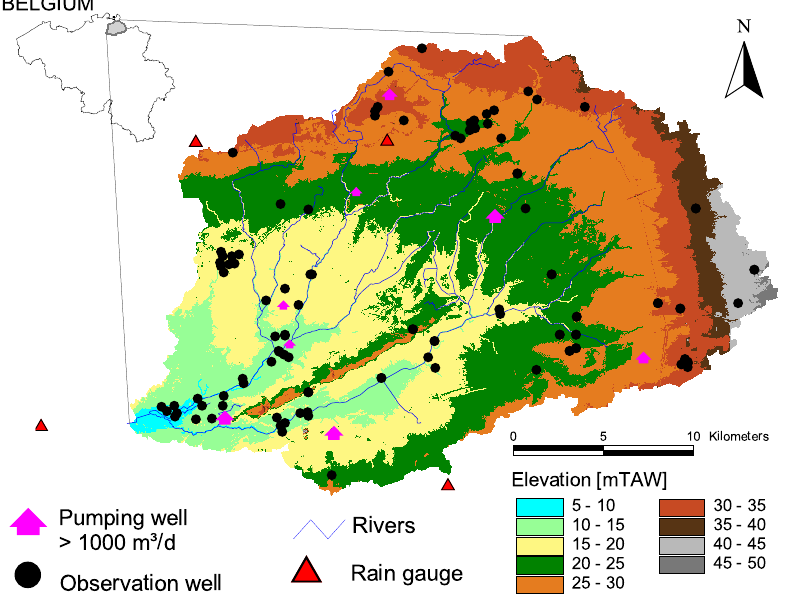
Fig. 1. Location and topography of the study area including the geographical position of the observation and most important pumping wells and rain gauges.